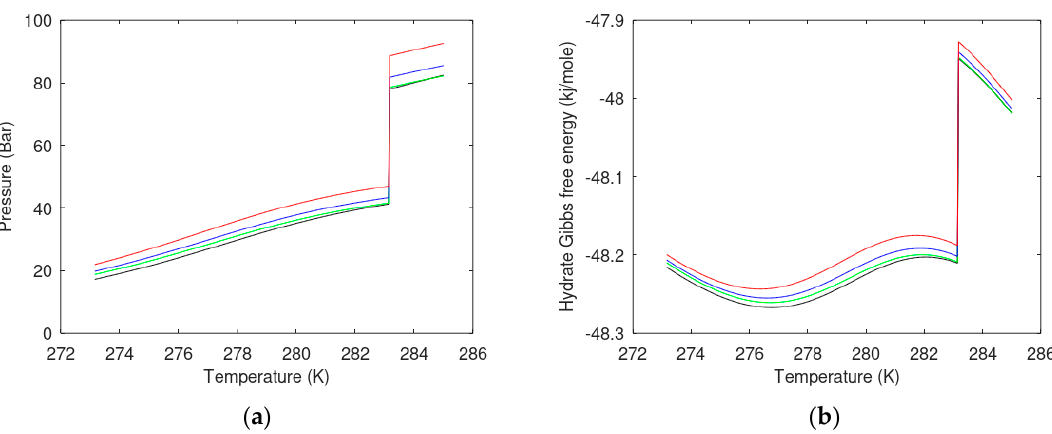
Figure 5. ( a ) Temperature pressure stability limits for mixed CO 2 /N 2 hydrate formed from a CO 2 /N 2 mixture with 20 mole percent N 2 and water containing ethanol. Black curve is for 0 mole-fraction ethanol, green curve is for 0.015 mole-fraction ethanol, blue curve is for 0.02 mole-fraction ethanol, and red curve is for 0.03 mole-fraction ethanol. ( b ) Gibbs free energy for hydrates formed from a CO 2 /N 2 mixture with 20 mole percent N 2 and water containing various concentrations of ethanol. The color notation is the same as in Figure 5a.